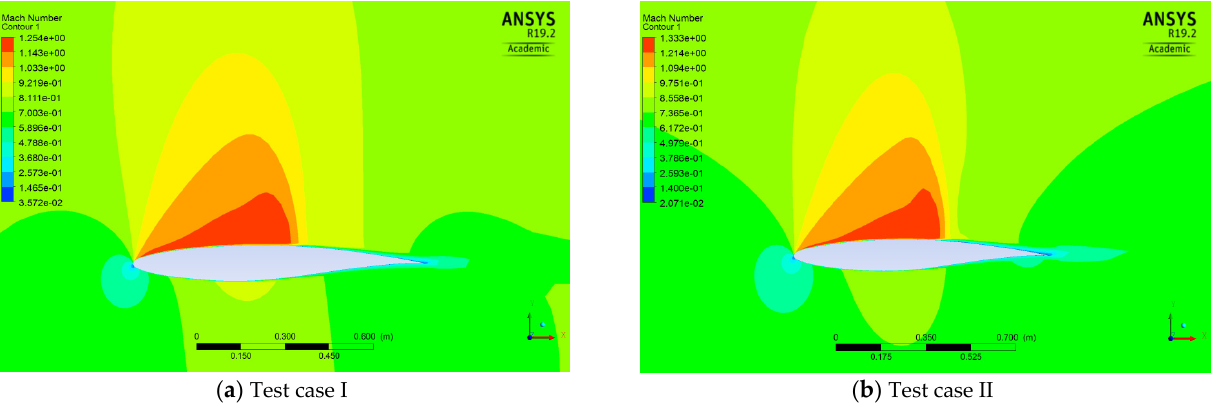
Figure 8. Comparison of surface pressure coefficient between the numerical solution (ANSYS Fluent, S-A turbulence model) and the experimental data [12] for the RAE2822 airfoil at the flow conditions: ( a ) Test case I: M ∞ = 0.729, α = 2.31 ◦ , and ( b ) Test case II: M ∞ = 0.734, α = 2.79 ◦ .